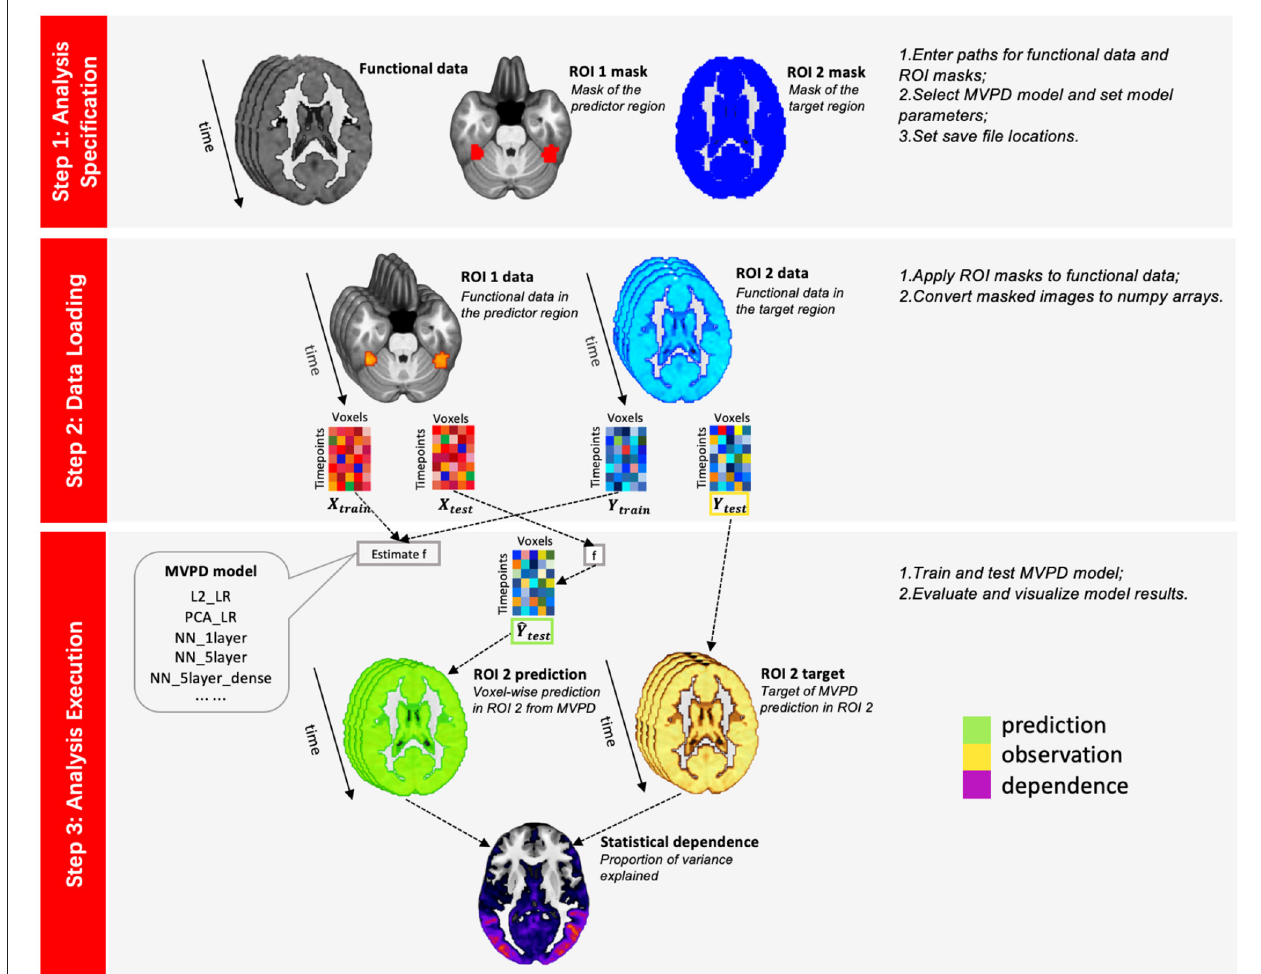
FIGURE 1 | PyMVPD workflow. Analyzing data with the PyMVPD toolbox consists of three steps: (1) analysis specification; (2) data loading; and (3) analysis execution. In step 1, users are required to specify the functional data, masks for both the predictor and the target region, as well as the type of MVPD model to perform the following analyses. These details can be specified by editing the Python script run_MVPD.py . Next, users can proceed with step 2, which loads neuroimaging data and converts it to a suitable format. Finally, step 3 runs the MVPD model and generates the analysis results, which are saved in a user-specified